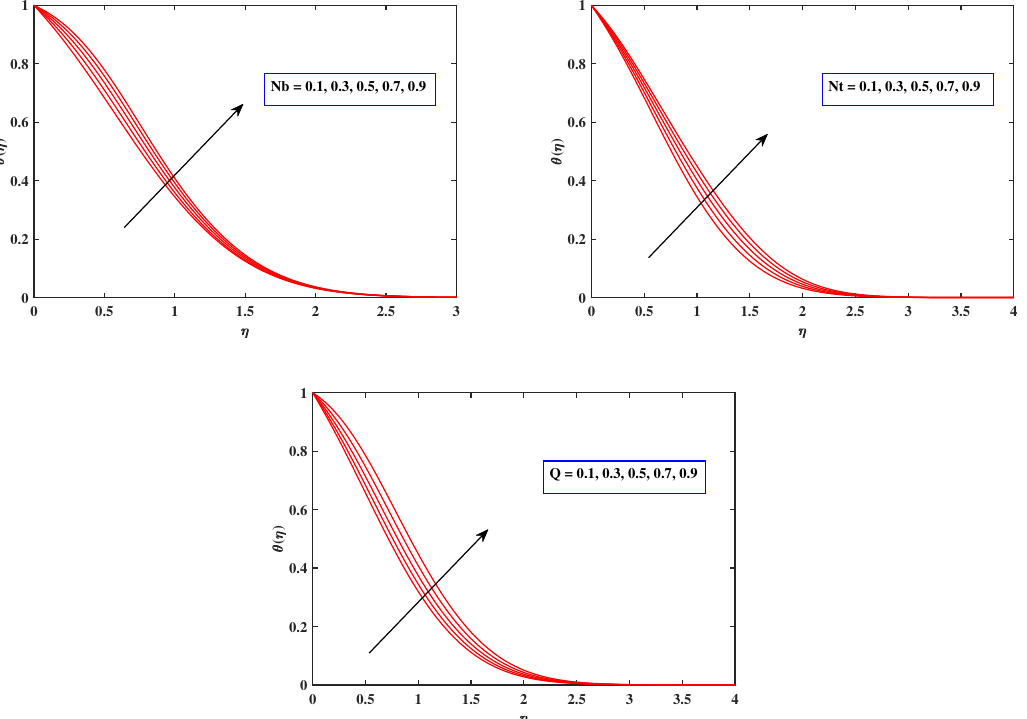
Figure 6. Fluctuation in temperature profile with Nb , Nt and Q